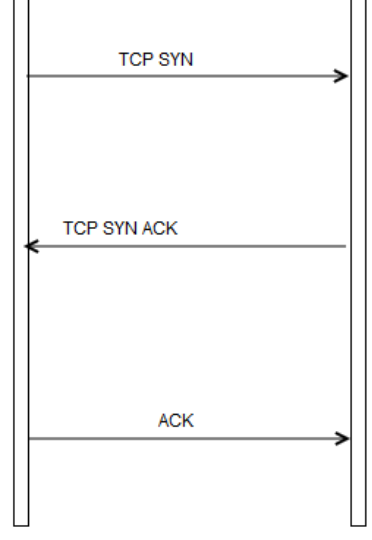
Table 1: Attacks Classification in various layers.